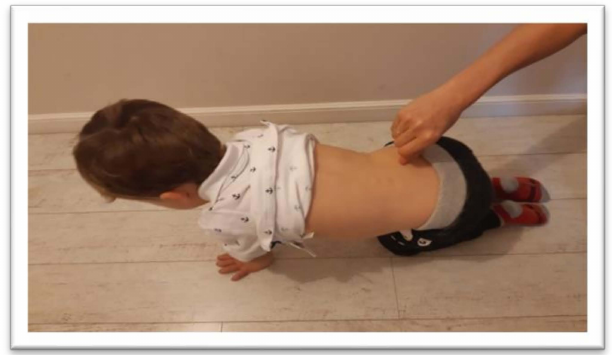
Figure 7. Position for the examination of ATNR for the right side.